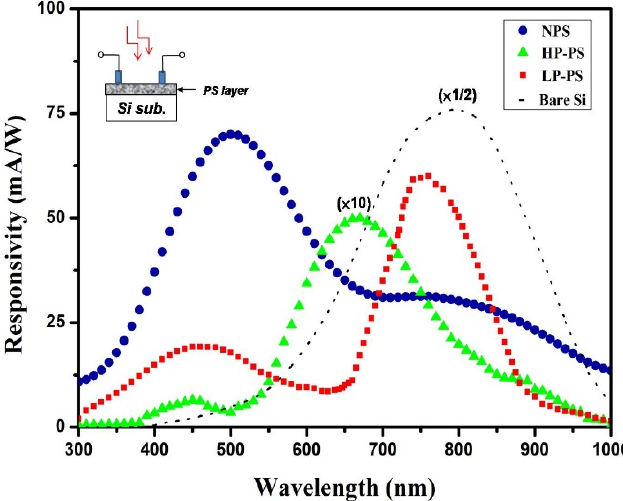
Figure 4. The spectral photoresponses of the individual PS (NPS, HP-PS or LP-PS) layer prepared on a Si substrate, measured with planar electrodes on the PS surface as indicated in the inserted drawing. For comparison purposes, the measured data of the bare Si substrate are also shown.